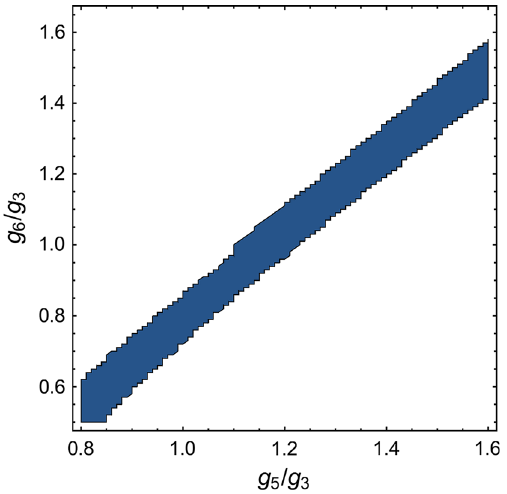
Fig. 4 Plot of the existence of an attractive non-trivial UV fixed point (blue) dependent on the higher couplings g 5 and g 6 . Here, the trilocal equation for the gravitational coupling g 4 was used, which allows us to switch off the R 2 coupling. We found two different fixed points with rather similar fixed point values. Each fixed point has its own area of existence in the theory space of the higher couplings. The blue area marks the unified area of both fixed points. Nevertheless, the area is significantly smaller than the areas displayed in Fig. 3. This reflects the importance of the R 2